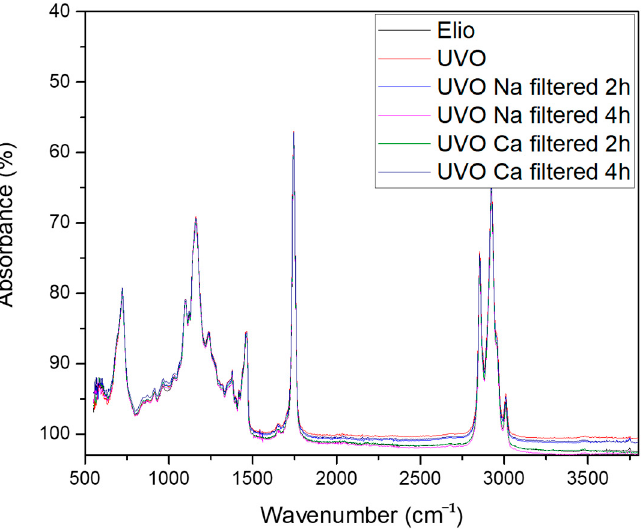
Figure 1. FT-IR spectra of edible oil Elio, Used Vegetable Oil (UVO), and UVO filtered, respectively) on Na and Ca clays (2 and 4 h).